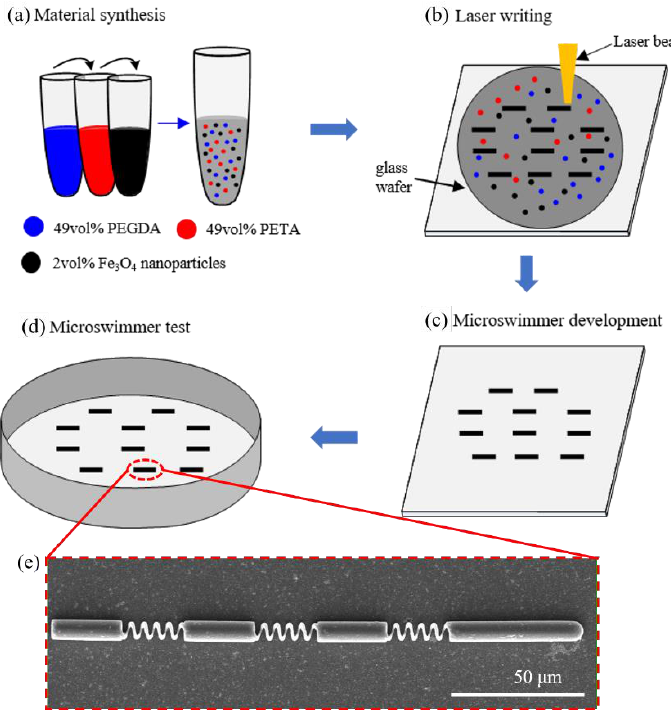
Figure 2. Fabrication process of the microswimmers: ( a ) material synthesis; ( b ) laser writing; ( c ) microswimmers development; ( d ) microswimmers test; and ( e ) scanning electron microscopy (SEM) image of the microswimmer.